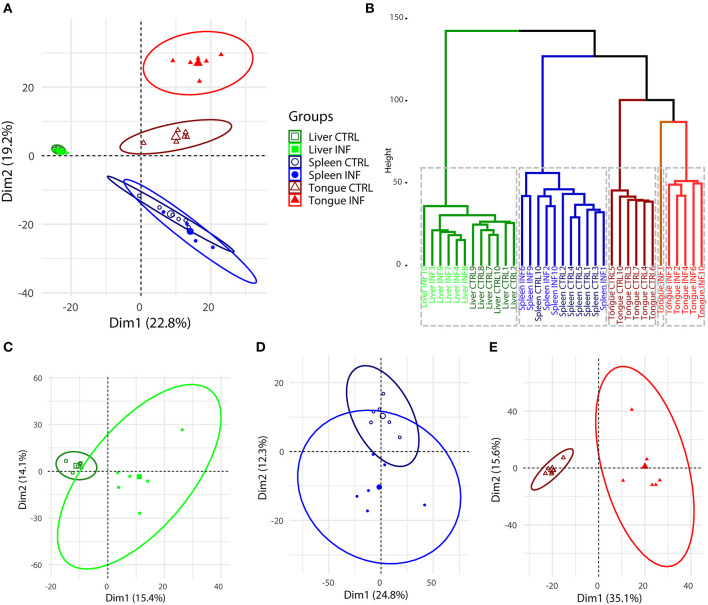
Principal component analysis (A) and hierarchical clustering (B) of all the individual samples and organs of Dicentrarchus labrax constructed based on the fragments per kilobase of transcript sequence per million (FPKM) values for each of the differentially regulated transcripts in Ceratothoa-infected (INF) vs. non-infected control (CTRL) fish. The optimal number of clusters in (B) was determined by the gap statistic (k = 5). Principal component analysis using all differentially expressed (DE) transcripts was also performed on the liver (C), spleen (D), and tongue (E) samples separately. The confidence level of the ellipses was 0.95 in all cases. The number of CTRL and INF samples was n = 6, except for INF spleen samples, where n = 5.